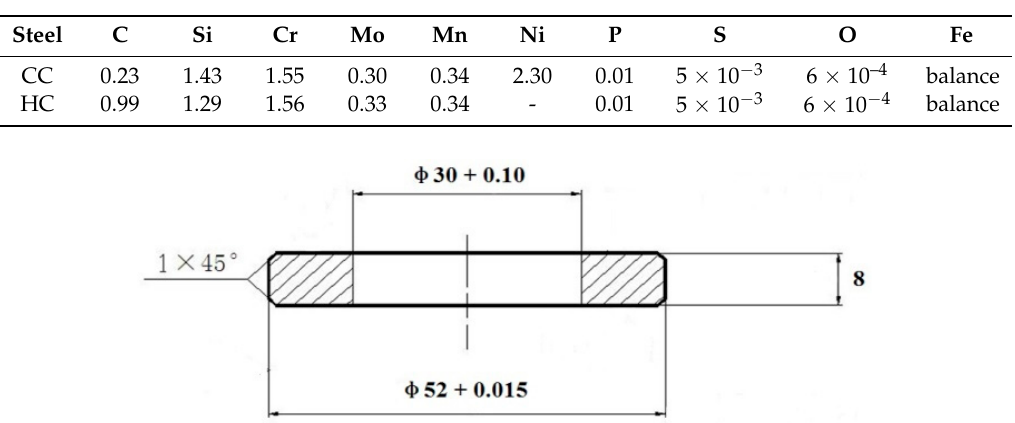
Table 1. Chemical compositions of the experimental steels (wt.%).